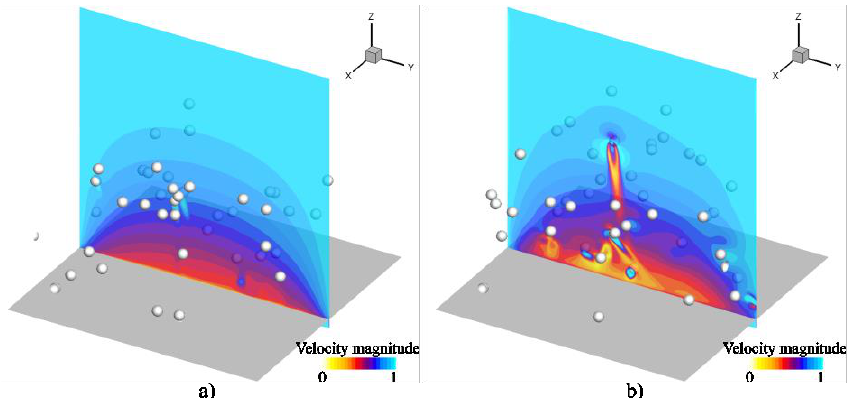
Figure 22. Flow distributions for schemes A050 ( a ) and B050 ( b ). The color map indicates the magnitude of the velocity.